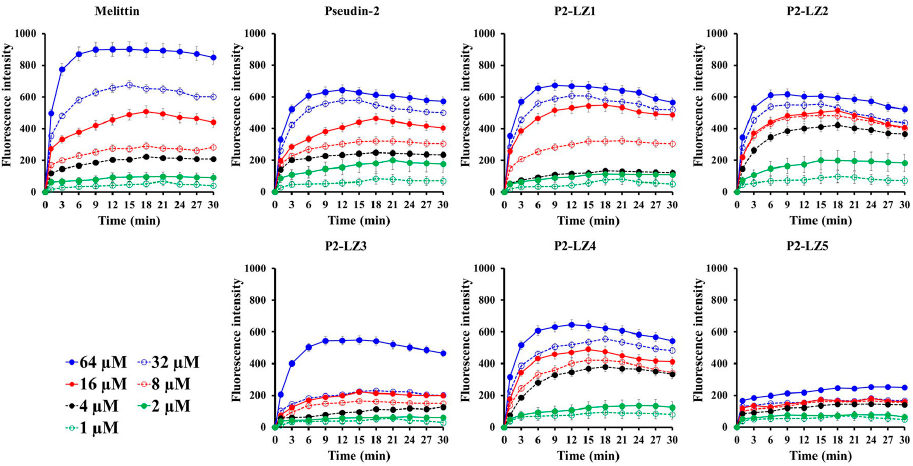
Figure 6. Membrane permeability of pseudin-2 and P2-LZ peptides in C. tropicalis cells. Data are expressed as the means ± standard deviation from three independent experiments.